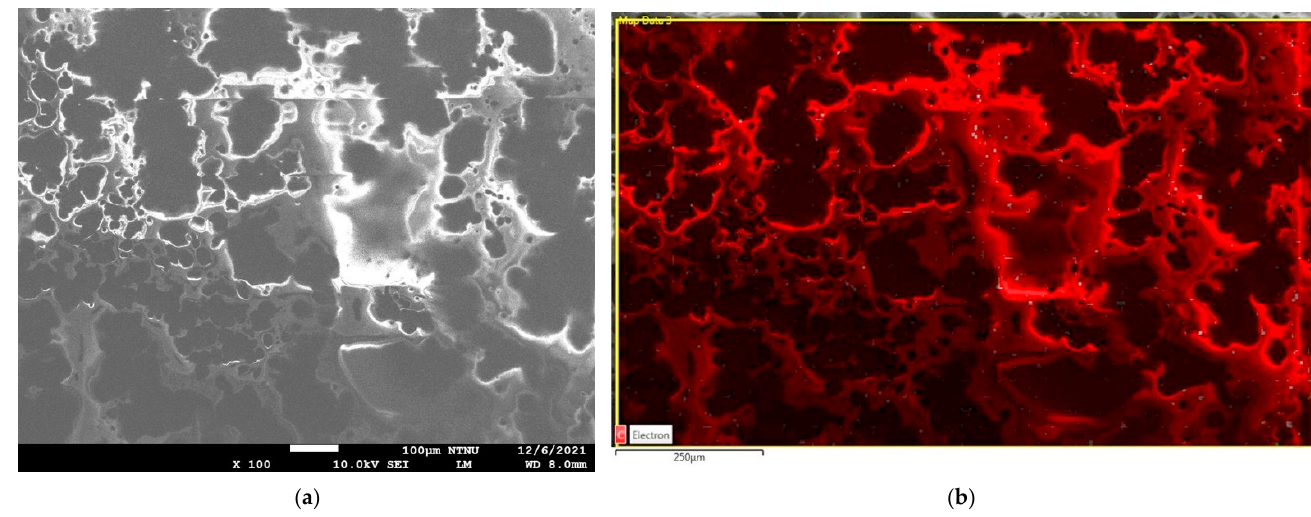
Figure 2. GNHC coating analysis: ( a ) SEM image; ( b ) elemental mapping of EDS.